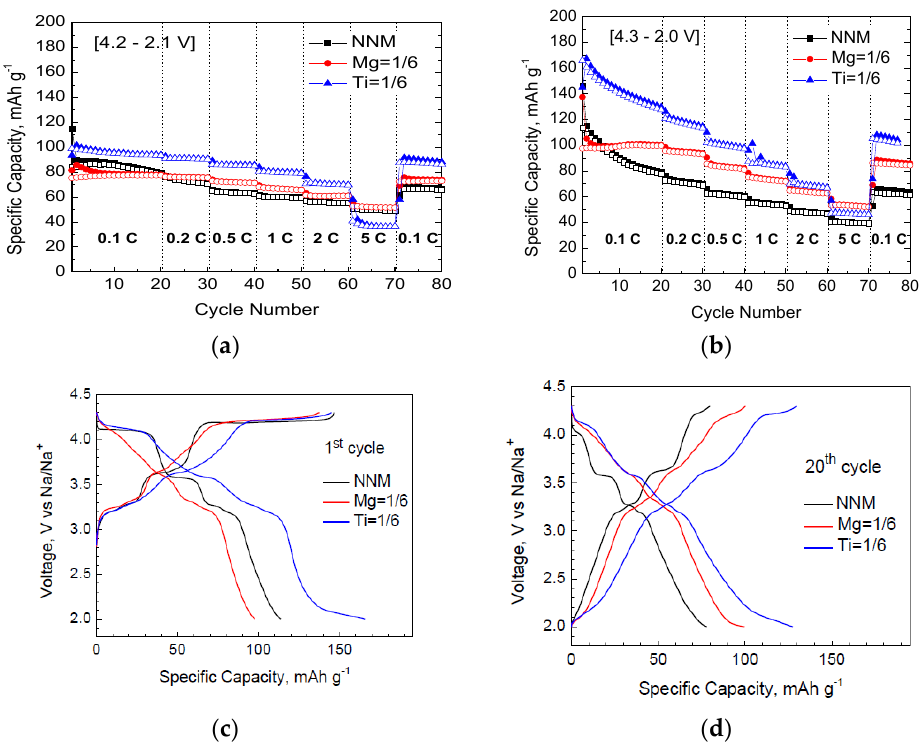
Figure 5. Specific capacity, cycling stability and rate capability for NNM, NM16 and NT16 in sodium-ion cells cycled in two voltage windows: ( a )—[4.2–2.1] V and ( b )—[4.3–2.0] V. Charge–dis-